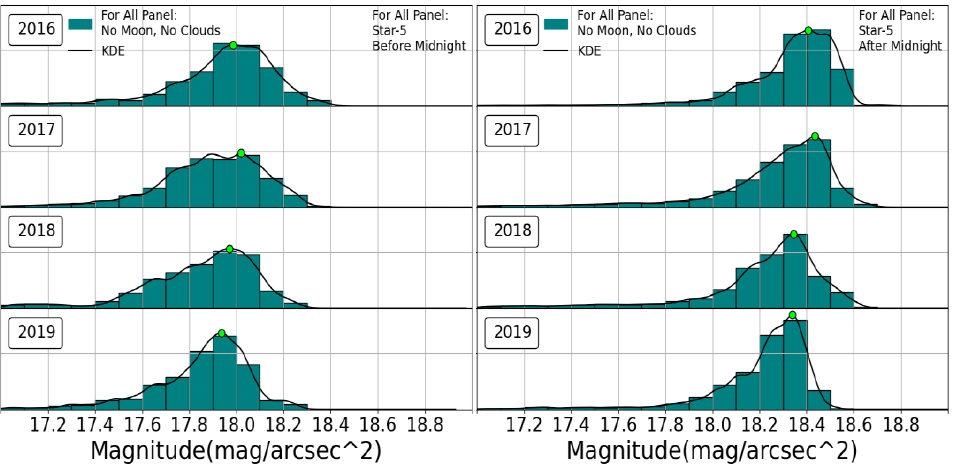
Figure 14. Histograms of night sky brightness values measured by TESS-W before ( left ) and after ( right ) midnight. The green points represent the mode.